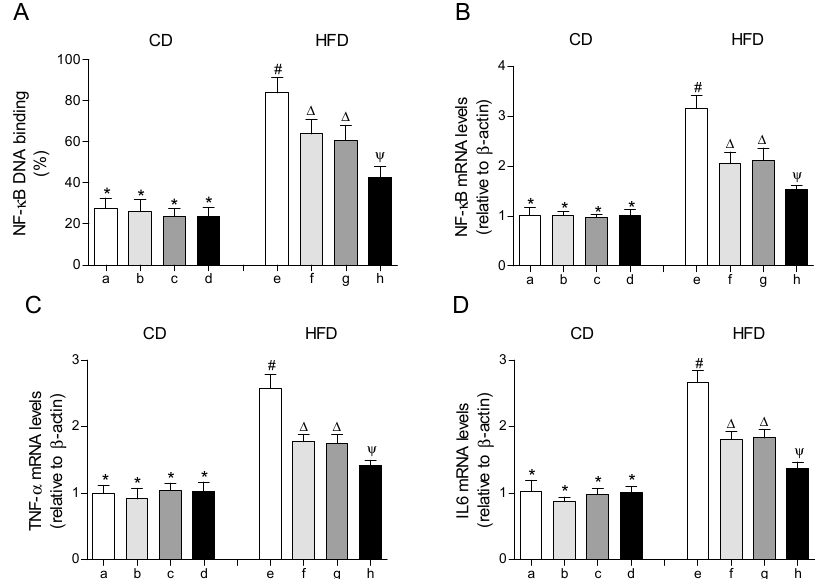
Figure 5. Nuclear factor erythroid 2–related factor 2 (NF- κ B) DNA-binding, ( A ) mRNA levels of NF- κ B, ( B ) mRNA levels of tumor necrosis factor (TNF- α ), ( C ) and mRNA levels of interleukin 6 (IL-6) ( D ) in epididymal white adipose tissue from mice subjected to control diet (CD) and high-fat diet (HFD) supplemented or not with eicosapentaenoic acid (EPA), hydroxytyrosol (HT) or EPA + HT. Groups that do not share the same superscript symbol were significantly different among them, namely, (a), CD + saline; (b) CD + EPA; (c) CD + HT; (d) CD + EPA + HT; (e), HFD + saline; (f) HFD + EPA, (g) HFD + HT; and (h), HFD + EPA + HT, according to two-way analysis of variance (ANOVA) followed by the Tukey’s post-test, p < 0.05. ( * ), does not differ from (a) group; ( # ), differ from (a) group; ( ∆ ), differ from (a) and (e) groups; ( Ψ ), differs from groups (a), (e) and those marked with the symbol ∆ .